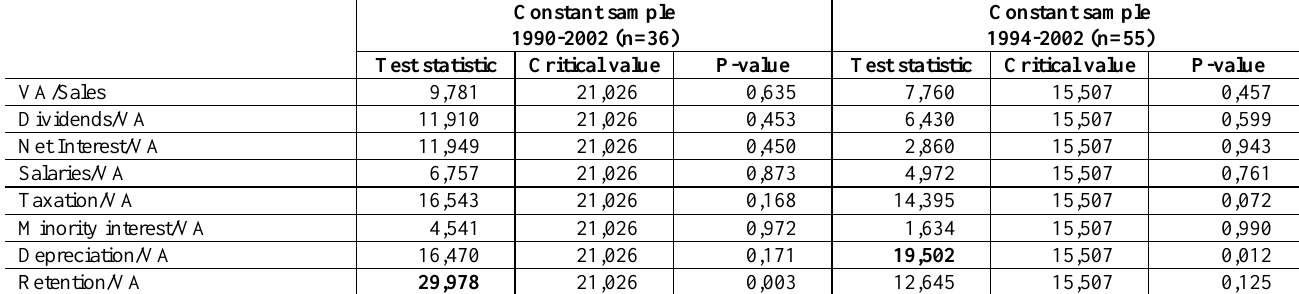
Table 7: Median of